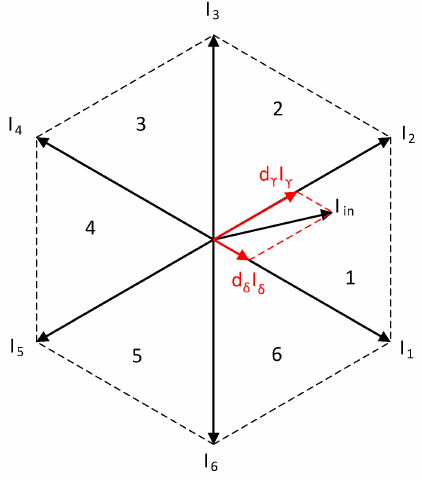
Figure 2. Input current hexagon.